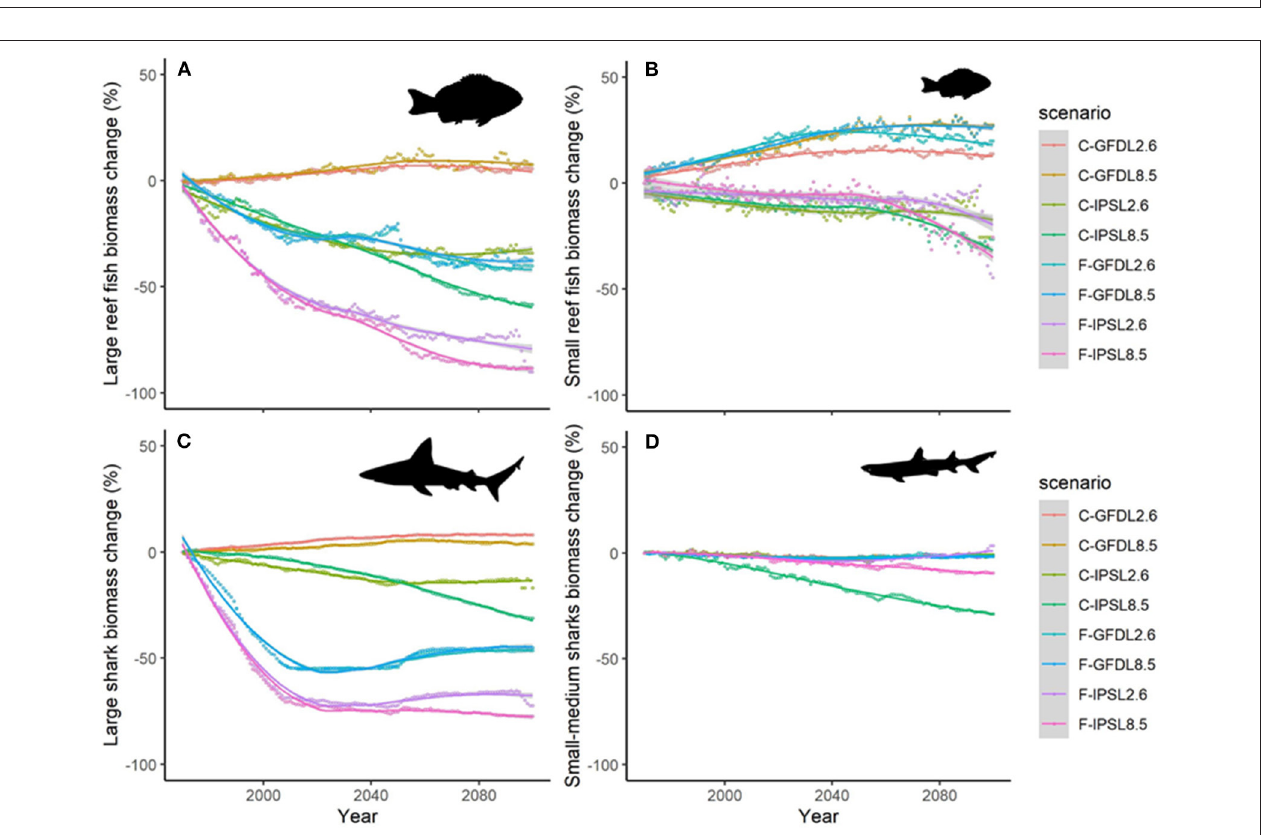
Frontiers in Marine Science |